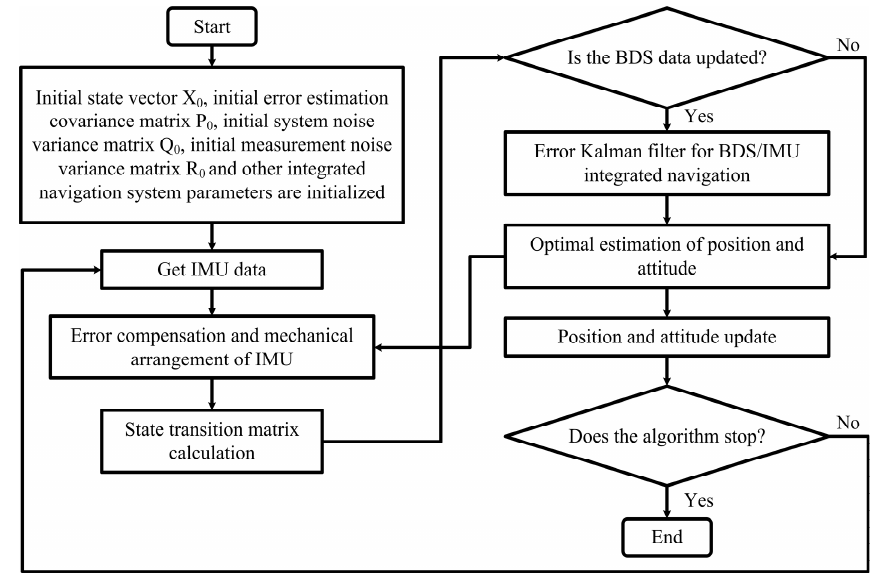
Figure 4. Flow chart of BDS/IMU integrated navigation based on error Kalman filter.